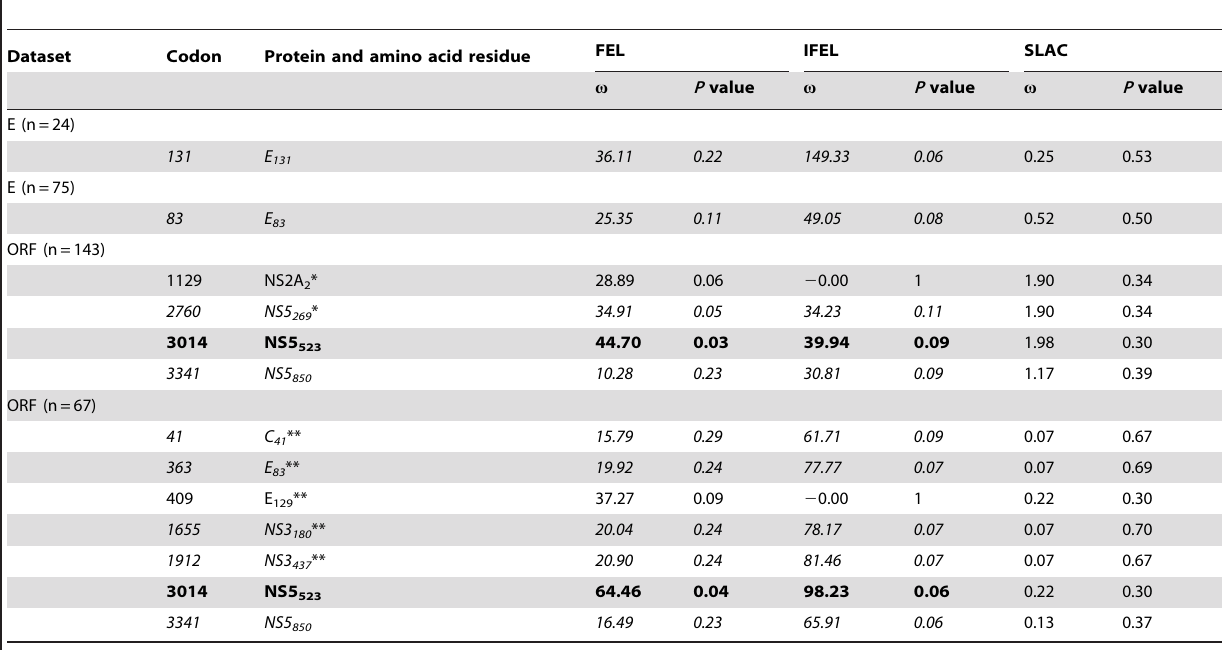
Table 1. Selection pressure analysis of the open reading frame (ORF) (3391 codons) and E protein gene (495 codons) datasets of DENV-2 from Central America, using the FEL, IFEL and SLAC methods employed in the Datamonkey server (www.datamonkey.org).